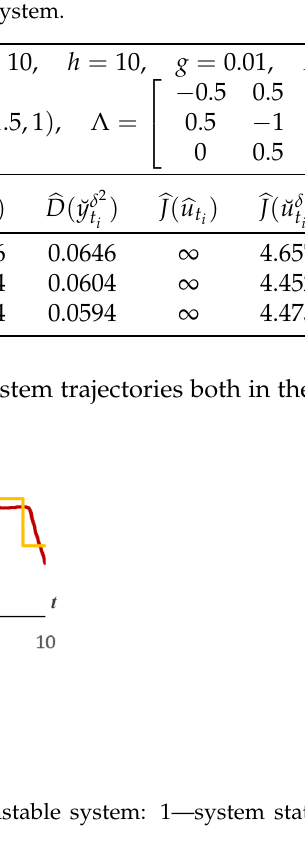
Figure 13. Typical trajectories of the unstable system: 1—system state, controlled by ˘ u δ uncontrolled system state; 3—drift Cy t